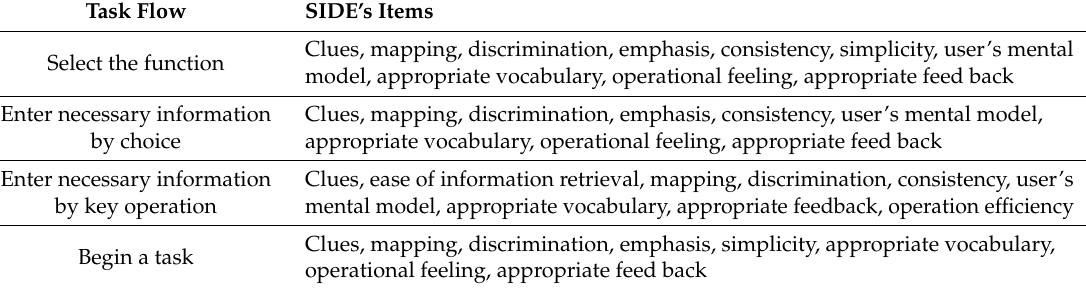
Table 2. Correspondence between task flow in patterns and structured user interface design and evaluation’s (SIDE’s) items (pattern 1).